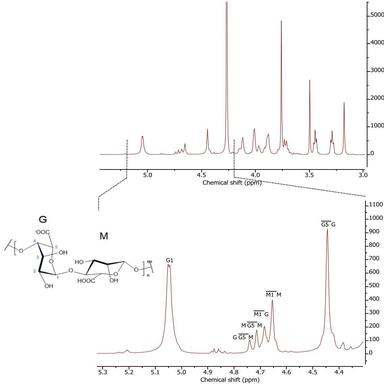
1 H NMR spectrum of unmodified alginate in D2O and schematic representation of G/M diads. The upper figure represents the spectrum of alginate in the range from 3.0 ppm to 6.0 ppm. The lower graph is the magnification of the region of interest (4.3–5.3 ppm). Peaks G1, GG5M, MG5M, M1G, M1M and G5G are located in 5.05 ppm. 4.74 ppm, 4.71 ppm, 4.68 ppm, 4.65 ppm and 4.45 ppm, respectively. The area under these peaks was used to calculate the G/M ratio of the unmodified sodium alginate.